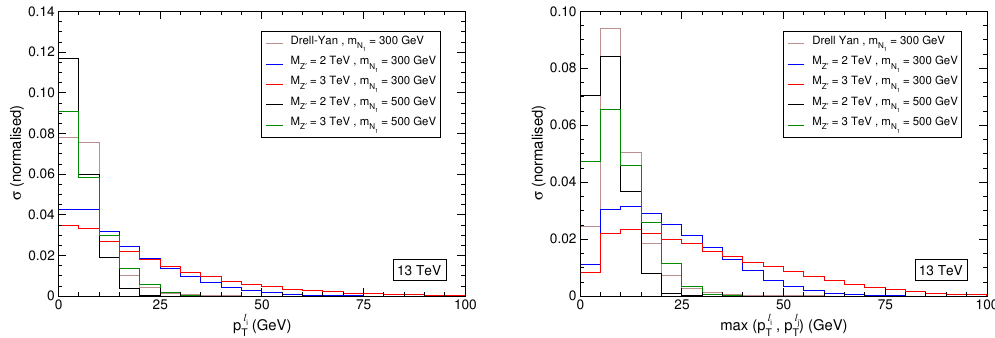
Figure 1 . Left: kinematical distributions of the transverse momentum at parton level of either lepton resulting from pp ! Z ( 0 ) ! N 2 N 2 , N 2 ! N 1 ‘ + ‘ (cid:0) . Right: kinematical distribution of the maximum of the transverse momenta of the two leptons resulting from the same N 2